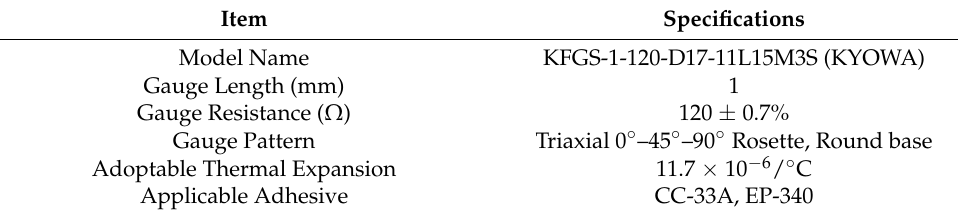
Figure 6. Location and pattern of the strain gauges attached on the test mockup: ( a ) photo of attached strain gauge; ( b ) strain gauge rosette pattern. Table 4. Specifications of the used strain